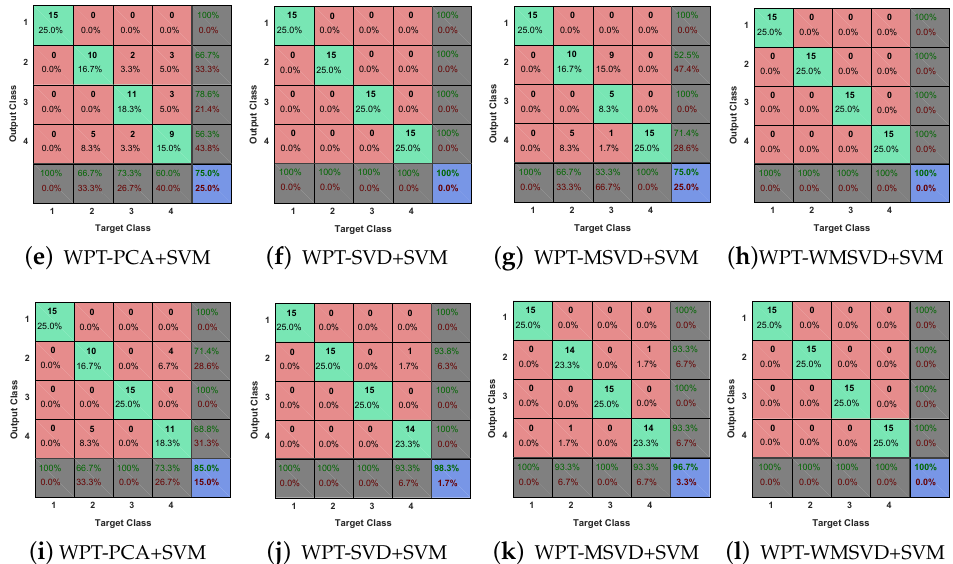
Figure 14. Classification confusion matrix of four algorithms: the minor fault ( a ) WPT-PCA+SVM; ( b ) WPT-SVD+SVM; ( c ) WPT-MSVD+SVM; ( d ) WPT-WMSVD+SVM; the general fault ( e ) WPT-